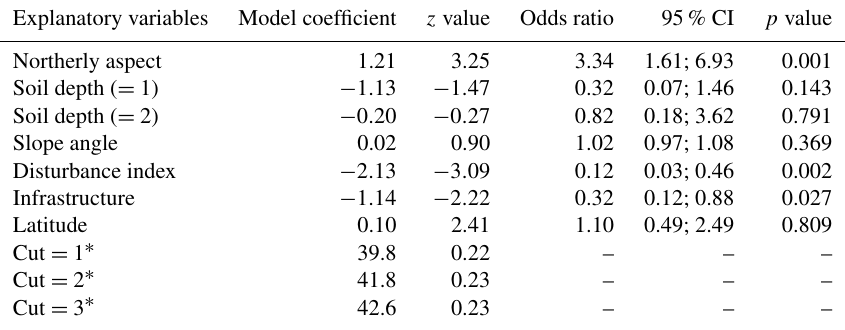
a Cut points representing the three different levels of the ordered logit